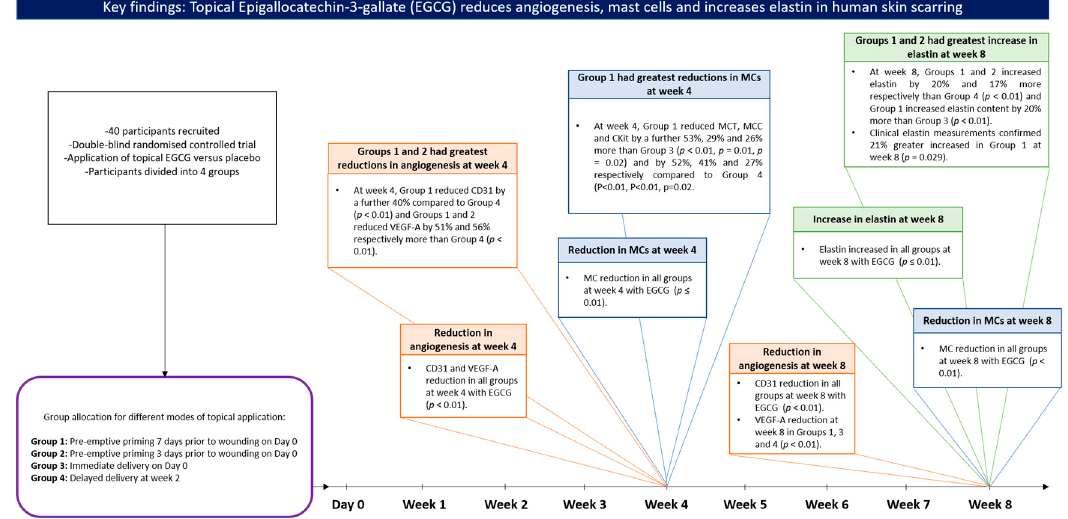
Figure 26. Key findings: Topical Epigallocatechin-3-gallate (EGCG) reduces angiogenesis, mast cells and increases elastin content in human skin scarring. A summary of the methodology of the study and the key outcomes linked with the corresponding time points.